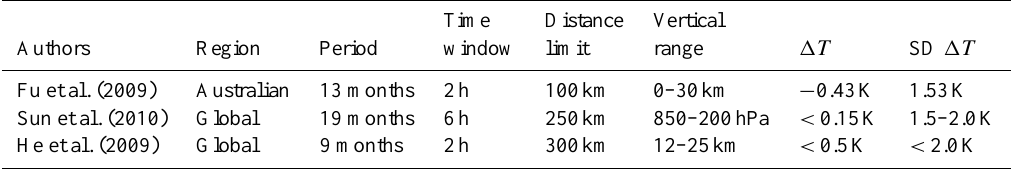
Table 1. Results of the temperature bias between COSMIC and radiosonde.